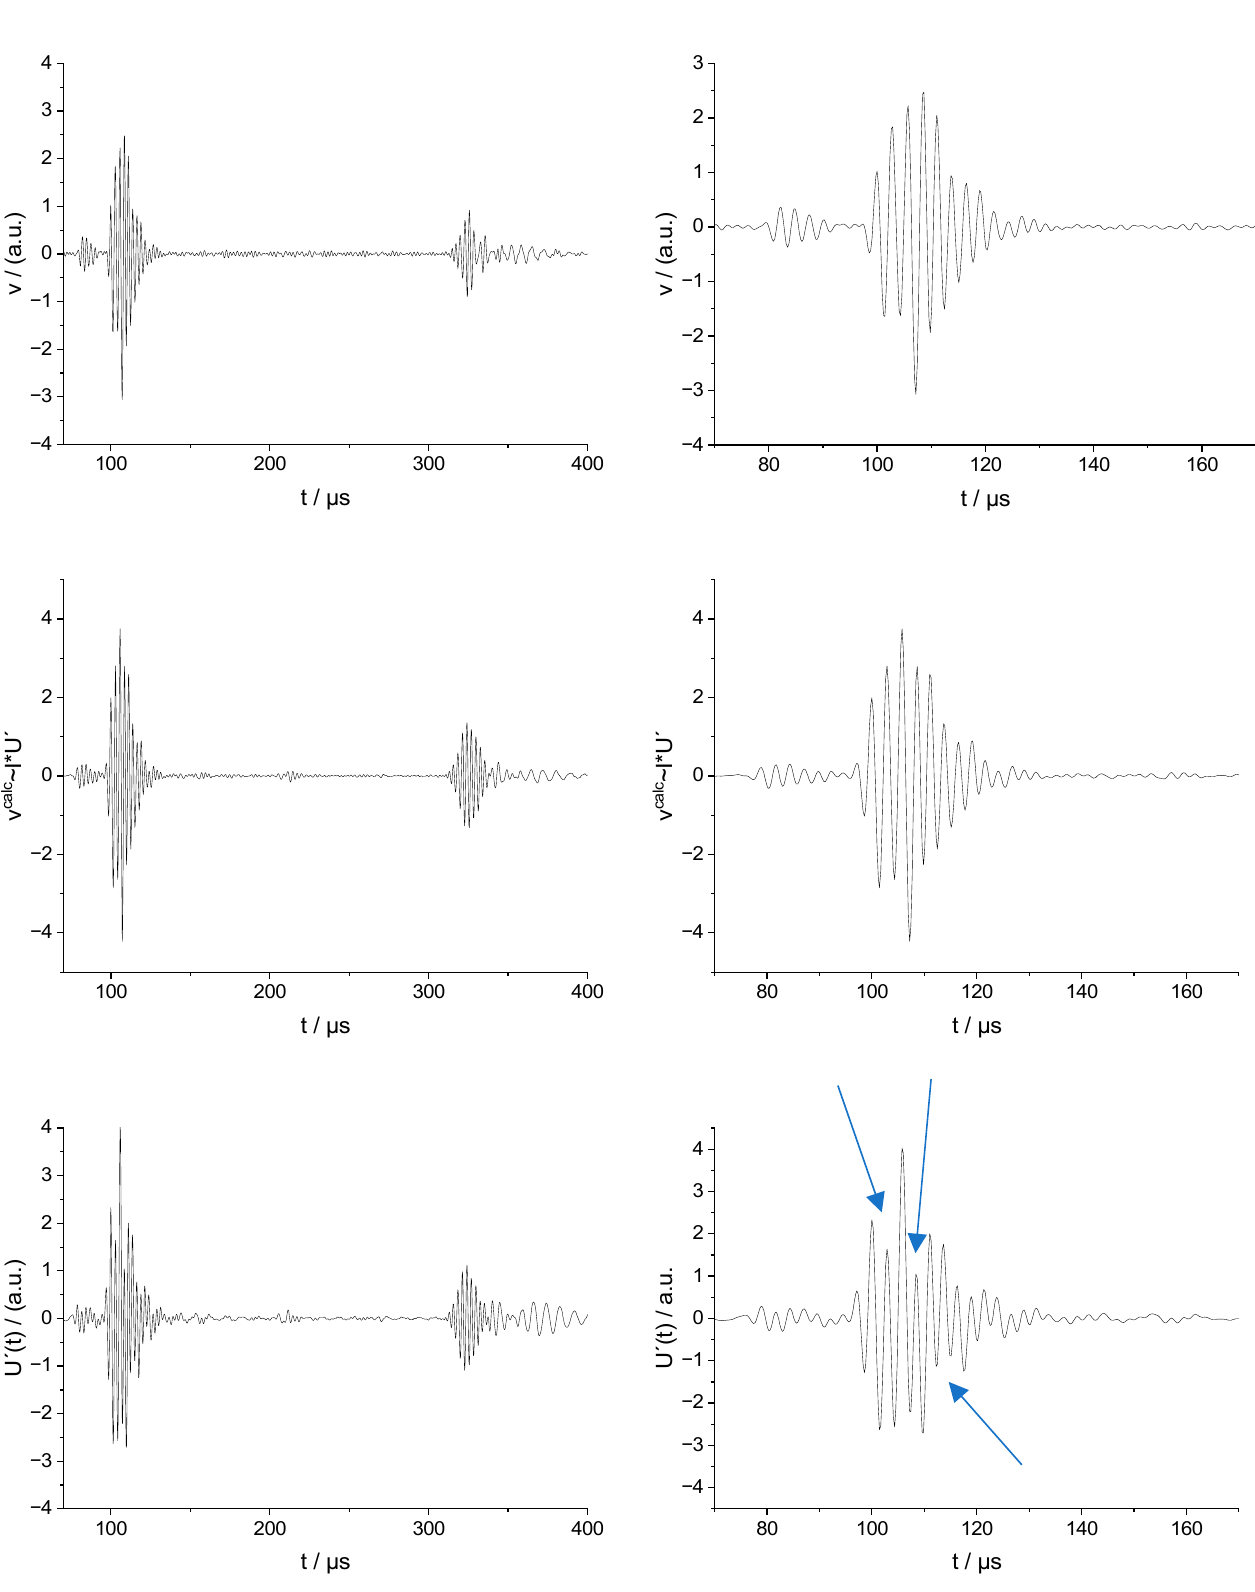
Figure 4. Comparison of the velocity signals. ( Top row ): velocity measured using LDV as response to the current signal I send ( t ) . (Middle row ): quantity v calc = I ∗ tr rec ∼ I ∗ U (cid:48) and ( Bottom row ): the quantity v calc _ II = U send ∗ tr rec ∼ U (cid:48) which must be equal to the measured v when the “presumed” reciprocity would be valid. The arrows indicate positions where v calc _ II significantly deviates from v .